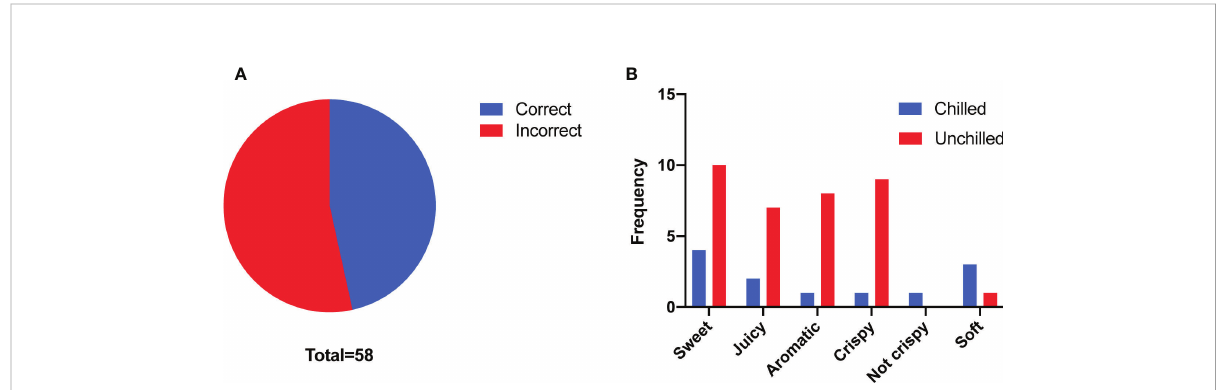
FIGURE 1 Consumer panel analyses. (A) Number of correct answers (n = 27) and incorrect answers (n = 31) from triangle test. (B) Taste descriptors for the chilled and unchilled melon fruit according to their frequency of use. Fewer panelists rated the chilled melon fruit as sweet, juicy and aromatic compared to the unchilled melon